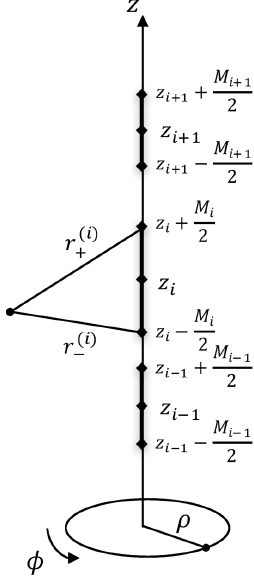
Figure 9. Schematic description of axisymmetric rod